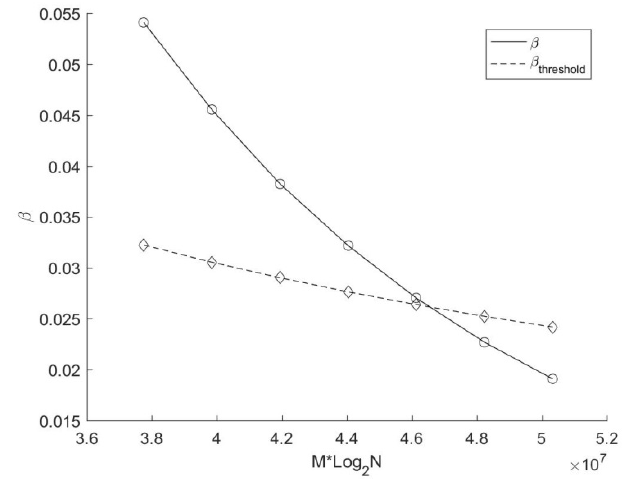
Figure 6. Variation of β and β threshold with different number of source points.